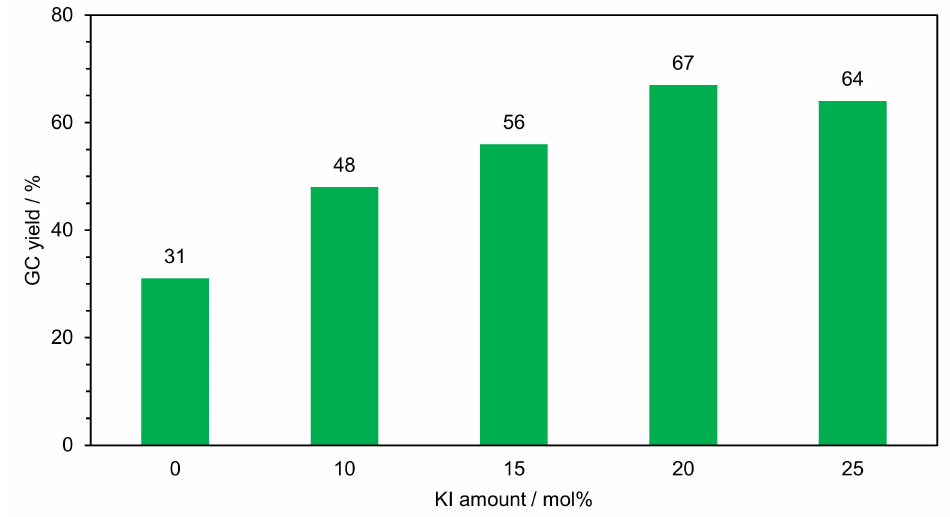
Figure 9. Effect of the amount of the KI additive on the product yield. Reaction conditions: 1,1- diphenylethylene (0.3 mmol); THF (1 mL); DTBP (4 equiv.); Cu 1 Ce 0.7 Si catalyst (5.6 mg); 120 ◦ C; under air for 20